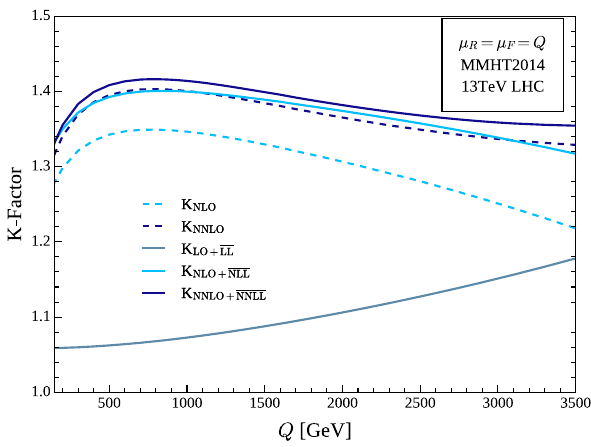
Fig. 2 K-factors till NNLO + NNLL level at the central scale Q = μ = μ R